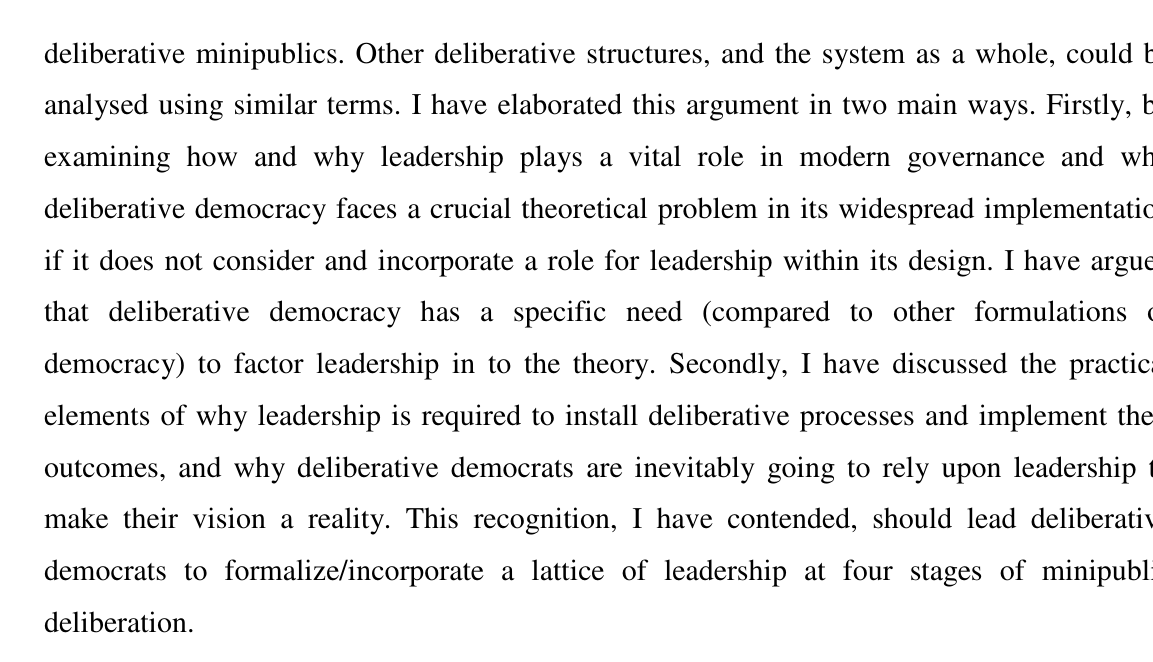
Table 1 – Minipublic Moments and the Lattice of Leadership